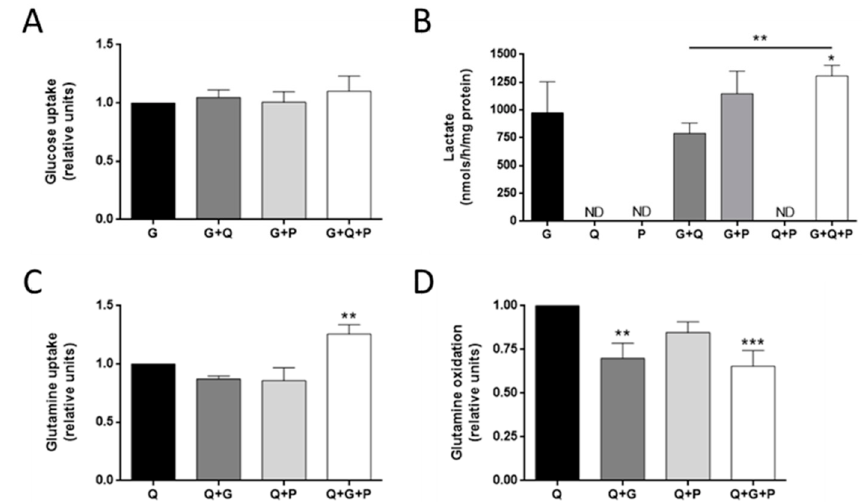
Figure 3. E ff ect of di ff erent metabolic fuels on glucose and glutamine metabolism in MDA-MB-231 cells. ( A ) Glucose uptake, ( B ) lactate secretion, ( C ) glutamine uptake, and ( D ) glutamine oxidation were determined after 30 min fast and 30 min incubation in the presence of 5 mM glucose, 0.5 mM glutamine, and / or 0.5 mM palmitate. Data are expressed as means ± SD of three independent experiments. * p < 0.05, ** p < 0.01, *** p < 0.001 versus glucose ( A , B ) or glutamine ( C , D ) condition. G—glucose; Q—glutamine; P—palmitate.